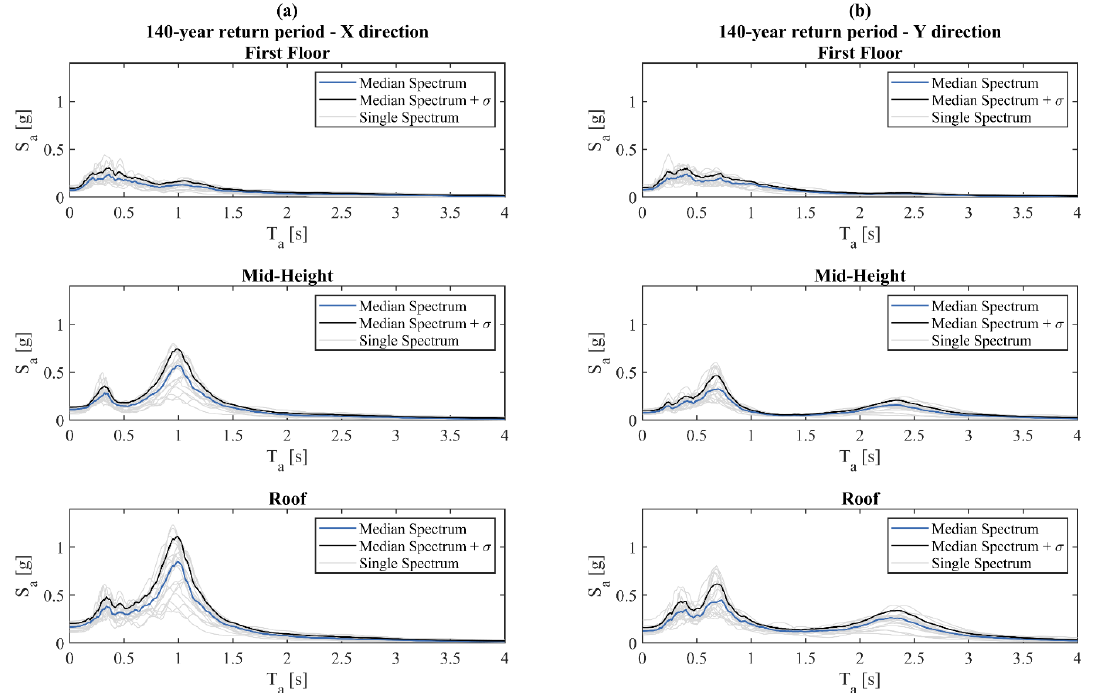
Figure 6. Individual and statistical acceleration floor spectra for RP = 140 years—First floor, mid-height and roof: ( a ) longitudinal, X direction; ( b ) transverse, Y direction.